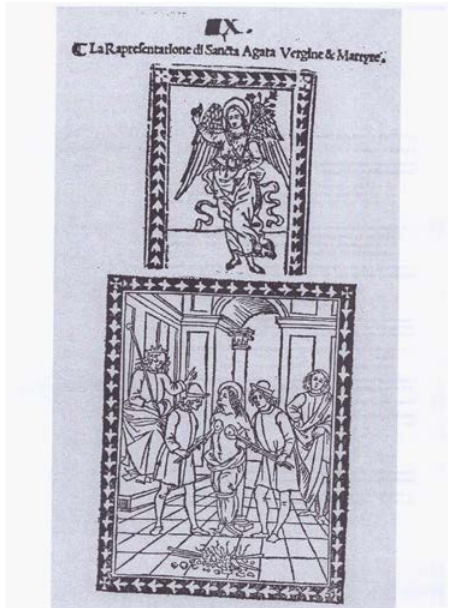
Figure 21 – La Rapresentatione di Sancta Agata Vergine & Martyre , ad instantia di ser Piero Pacini da Pescia, s.l.a. [but Firenze, Bartolomeo de’ Libri, around 1496?], f. a1r (BNCF, Banco Rari 179.8). By permission of Ministero per i beni e le attività culturali / Biblioteca Nazionale Centrale.